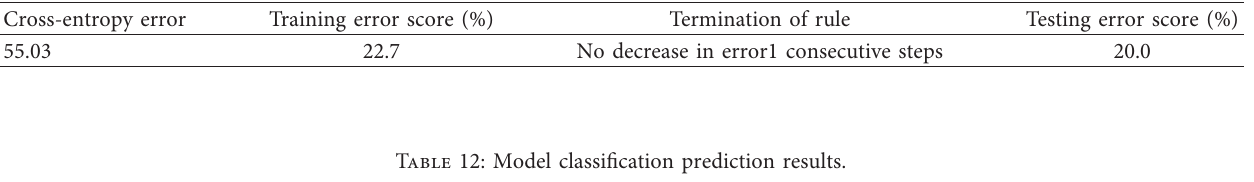
Table 11: Model summary.